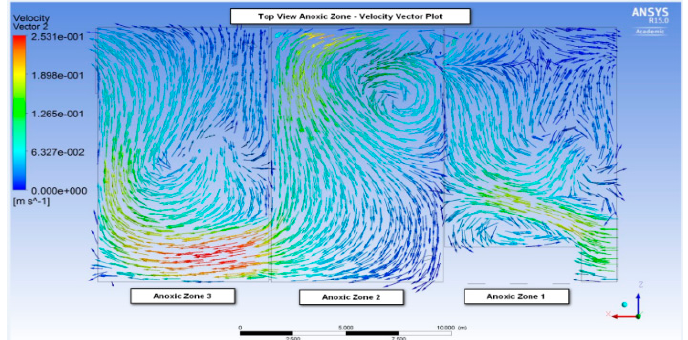
Figure 6. Velocity vector plot 1-m depth.